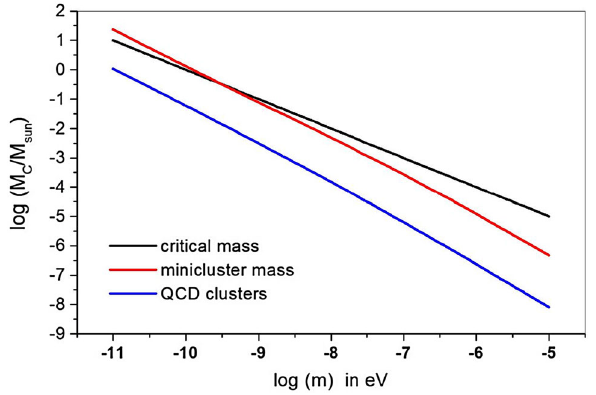
Fig. 2 The mass of axionic miniclusters as a function of the axion mass for two different temperature evolution models [13]. The blue curve corresponds to QCD axions while the red curve corresponds to a rapid variation of the axion mass with temperature. The black curve corresponds to the critical mass derived by [2]